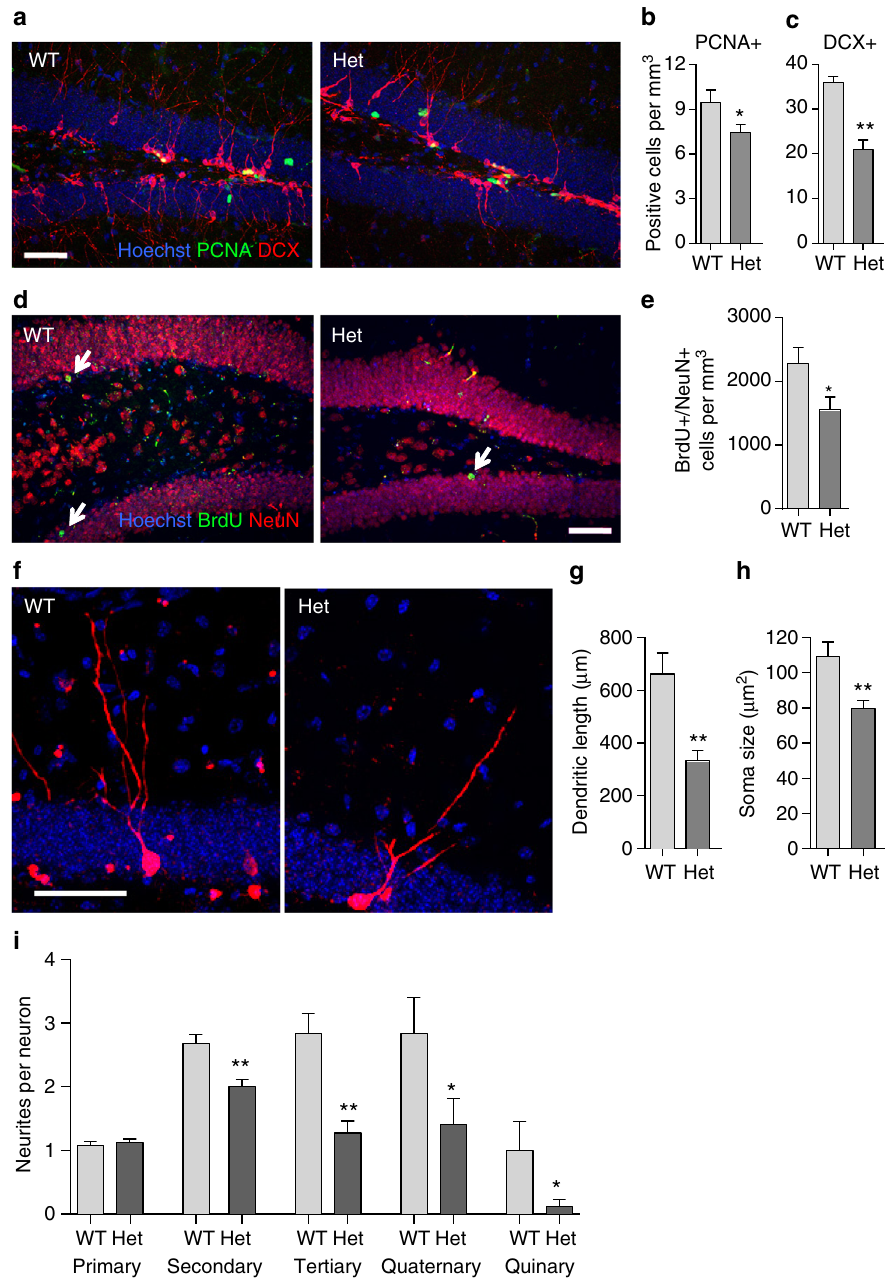
Fig. 4 Mef2c -het mice exhibit abnormal adult neurogenesis. a Confocal images showing PCNA (green) and DCX (red) double staining in the subgranular zone (SGZ) of the DG in 8-week-old WT and Mef2c -het mice. b , c Quanti fi cation of PCNA+ and DCX+ cells revealed reduction in the number of proliferating cells ( b ) and developing neurons ( c ) in Mef2c -het DG. d BrdU (green) and NeuN (red) double staining 4 weeks after BrdU injection in 8-week- old WT and Mef2c -het mice revealed newly born DG neurons (arrows: BrdU+/NeuN+). e Reduction in BrdU+/NeuN+ cells in Mef2c -het DG; n = 4 mice per genotype in a – e . f Examples of morphological development of neurons born in adult Mef2c -het and WT mice. Dividing cells in the dentate gyrus (DG) were labeled with mCherry via retroviral-mediated gene transduction. Mice were killed 4 weeks later. g Quanti fi cation of total dendritic length of 4-week-old neurons revealed reduced dendritic length in Mef2c- het mice ( n = 17) compared to WT mice ( n = 12). h Quanti fi cation showed reduced somal size in Mef2c -het mice ( n = 71) compared to WT mice ( n = 28). i Quanti fi cation of neurite number showed normal number of primary neurites ( n 55), but reduced number of secondary ( n WT = 25, n Het = 55), tertiary ( n WT = 25, n Het = 55), quaternary ( n WT = 12, n Het = 17), and quinary ( n WT = 12, n Het = 17) neurites of 4-week-old neurons in Mef2c -het compared to WT brain. Section thickness: 40 µ m. Scale bar: 50 µ m. Values are mean ± s.e.m., * P < 0.05; *** P < 0.001 by Student ’ s t